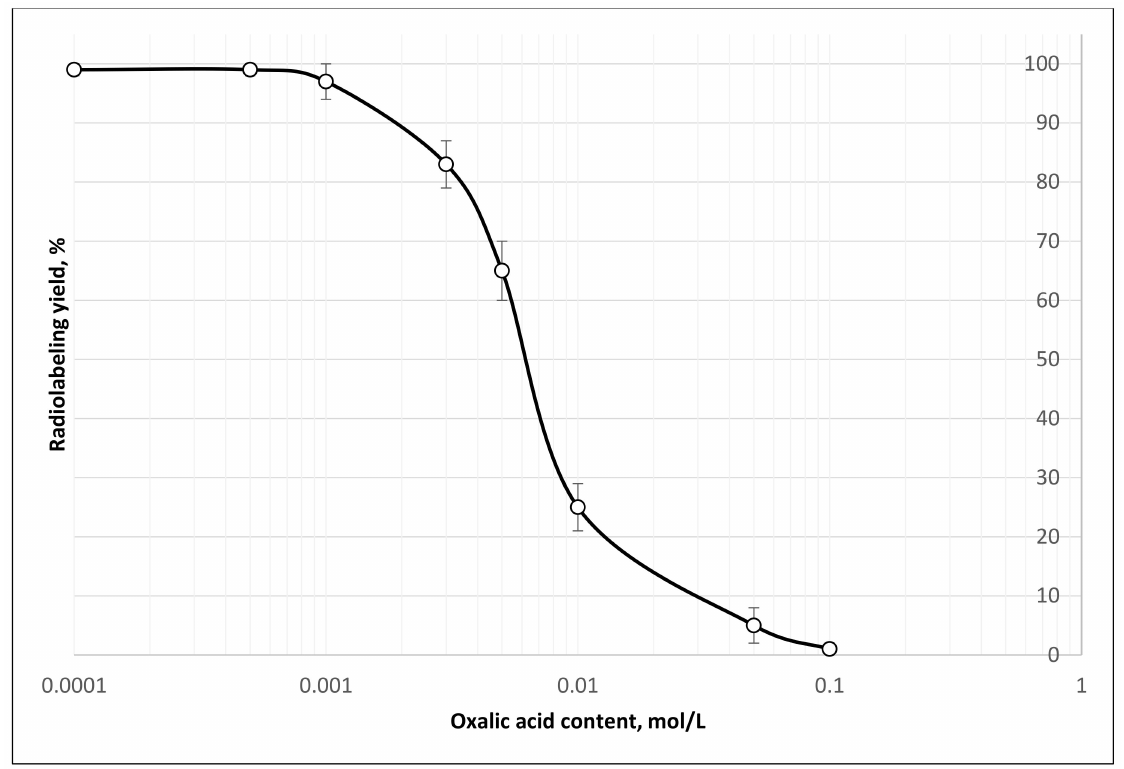
Figure 7. [ 44 Sc]Sc-PSMA-617 radiolabeling yield depends on oxalate concentration in the reaction mixture (mean ± SD, %; n = 3). Experimental conditions: convection heating 95 ◦ C, 30 min, V = 1.5 mL, pH = 4.5, 20 nmol PSMA-617.